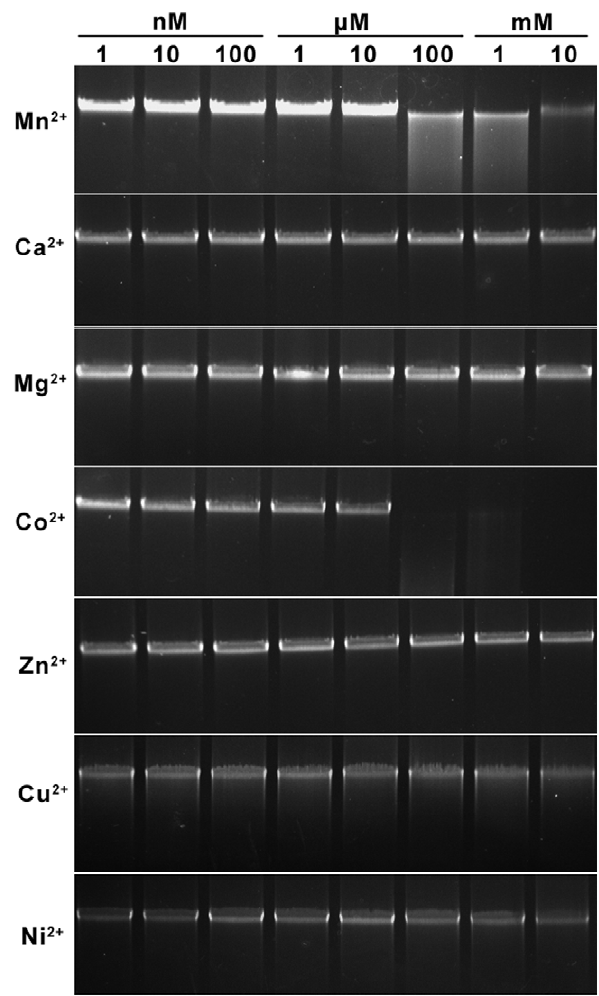
Figure 3. Divalent cation ion requirements analysis for the cleavage of S. lividans 1326 total DNA by Sco4631. Total S. lividans 1326 DNA (100 ng) prepared by the Kirby mix procedure [11] was used as a substrate to react with 500 ng purified His 6 -Sco4631 protein at 30 u C for 5 min in a total reaction volume of 20 m l. The metal ions added to the reaction buffer are indicated to the left, and the concentrations are above the lanes. The reactions were stopped by adding loading buffer containing 1% SDS, 50% glycerol and 0.05% bromophenol blue (Takara). After the reaction, the DNA samples were examined by 0.75% agarose gel electrophoresis. The gel was run at 5 V/ cm for 30 min and visualized by staining with ethidium bromide. The strong bands are high molecular weight DNA; the smear observed with Mn 2 + and Co 2 + concentrations $ 100 m M indicates DNA cleavage by